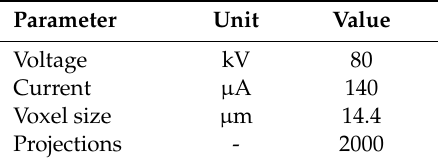
Table 4. µ CT scan parameters GE v | tome | x m 240 / 180.